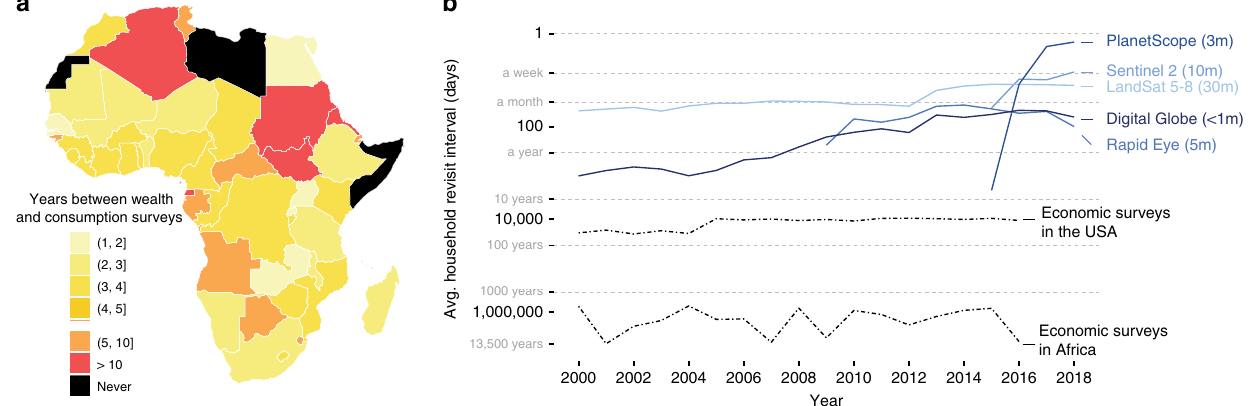
Fig. 1 Economic data from household surveys are infrequent in many African countries. a Frequency of nationally representative household consumption expenditure or asset wealth surveys across Africa, 2000 – 2016. b Average household revisit rate for surveys and average location revisit rate for various resolutions of satellite imagery over time. Survey revisit rate, the average time elapsed between observations of a given household in nationally representative expenditure or wealth surveys, is calculated as number of total person-days (population × 365) divided by the number of person-days observed in a given year. Satellite revisit rate estimates are calculated as the number of days in a year divided by the average number of images taken in a year across 500 randomly sampled DHS clusters in African countries, only counting images with <30% cloud